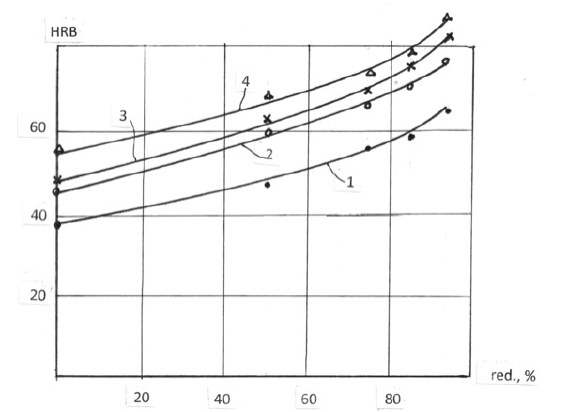
Figure 9. Effect of rolling reduction on hardness of AA5083: 1—as-received material; 2—over-aged material + four (D) sc-ECAE passes; 3—as-received material + four (D) sc-ECAE passes; 4—solution- treated material + four (D) sc-ECAE passes.